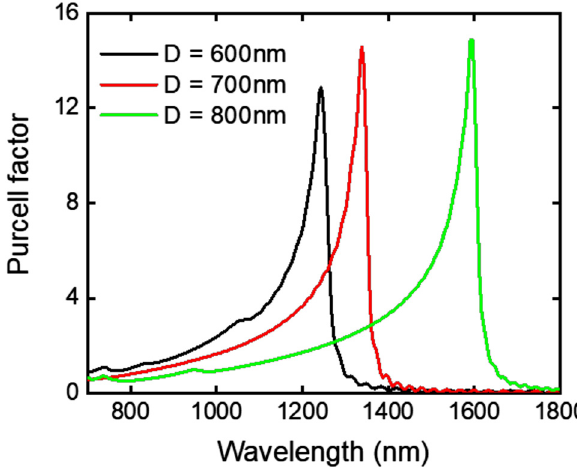
Figure 3: Decay rate enhancement for different core diameters D of the rolled-up zero-index